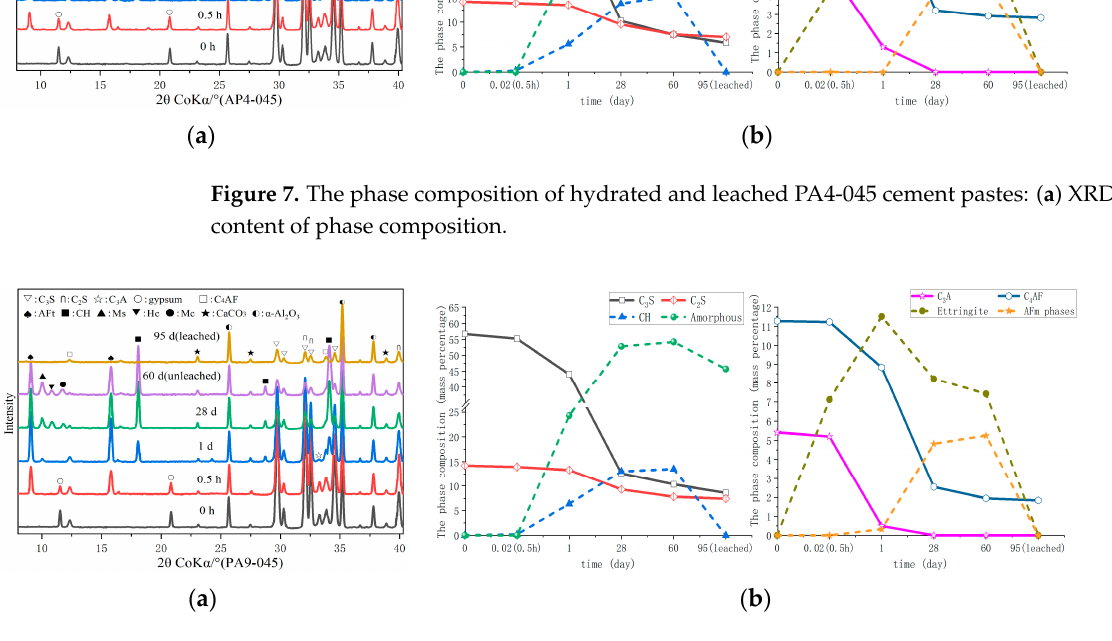
Figure 7. The phase composition of hydrated and leached PA4-045 cement pastes: ( a ) XRD; ( b ) the content of phase composition.